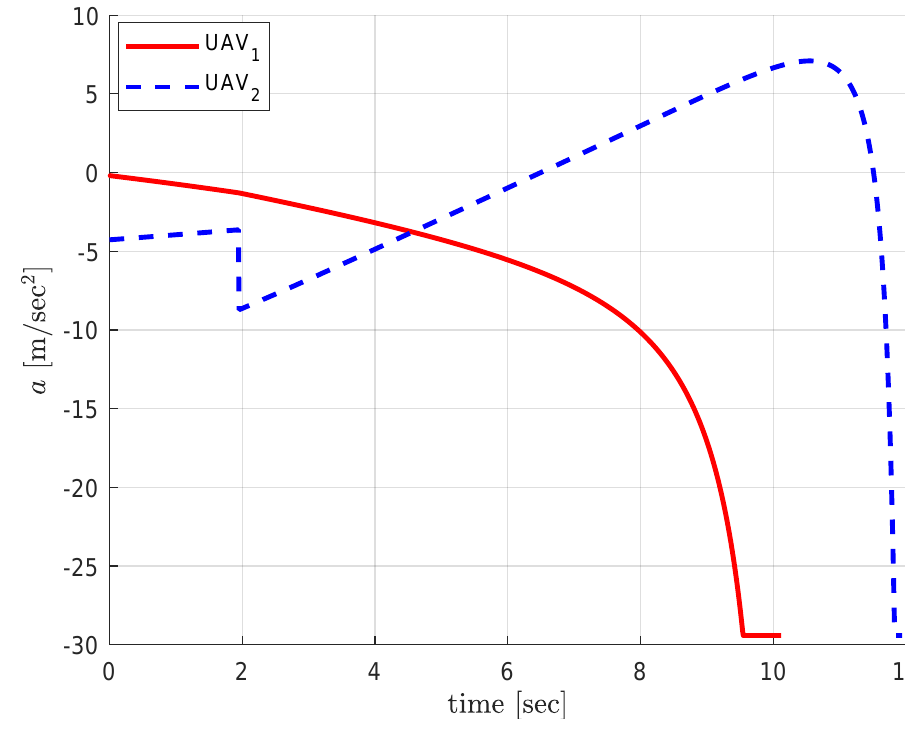
Figure 4. Centralized cooperation: guidance